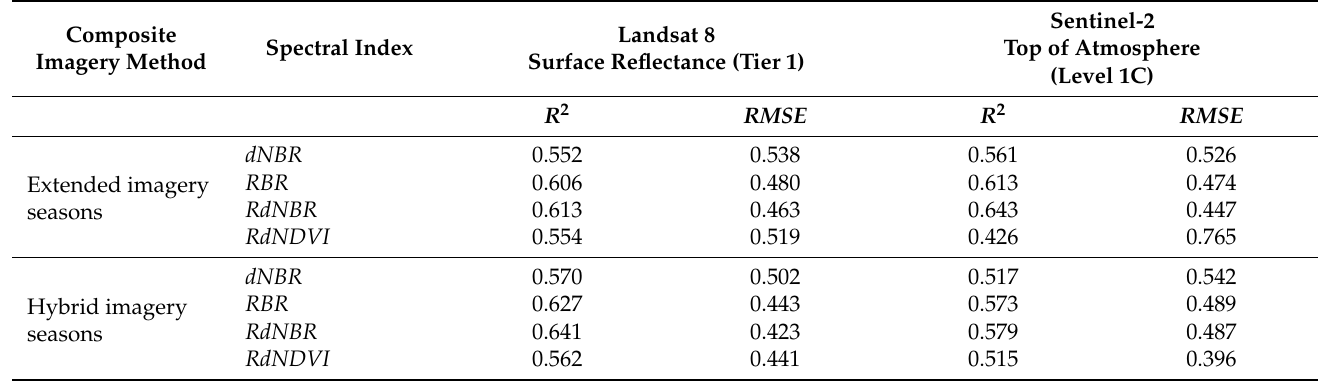
Table 4. Composite imagery method model fit ( R 2 ) and normalized root-mean-square error ( RMSE ) for non-linear least squares regression between composite burn index (CBI) plots and remotely sensed burn severity estimates using either Landsat or Sentinel imagery. Results are presented for the four spectral indices tested and computed using pre- and post-fire imagery composited using either the extended or hybrid imagery seasons (see Table 3). Models were fit to the combined dataset of 912 CBI plots from all 26